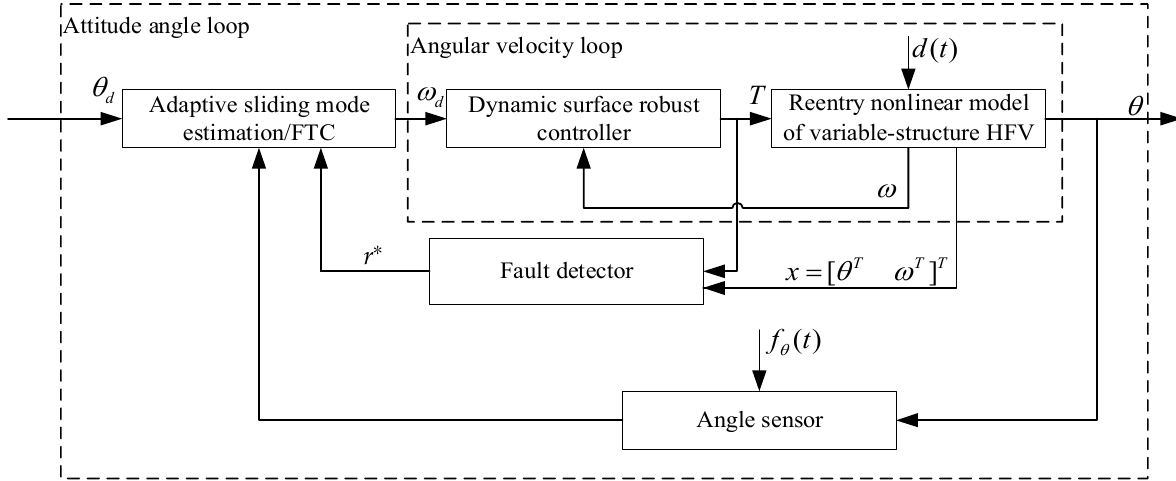
Figure 1. Block diagram of FTC for sensor faults in reentry attitude system.